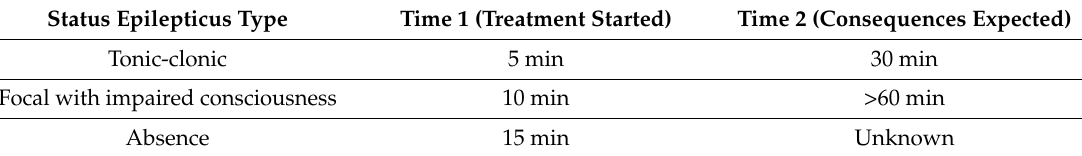
Table 1. International League Against Epilepsy definition of status epilepticus indicates that emergency treatment of status epilepticus should be started at t 1 and long-term consequences may occur at t 2 . Adopted from Trinka et al. , 2015